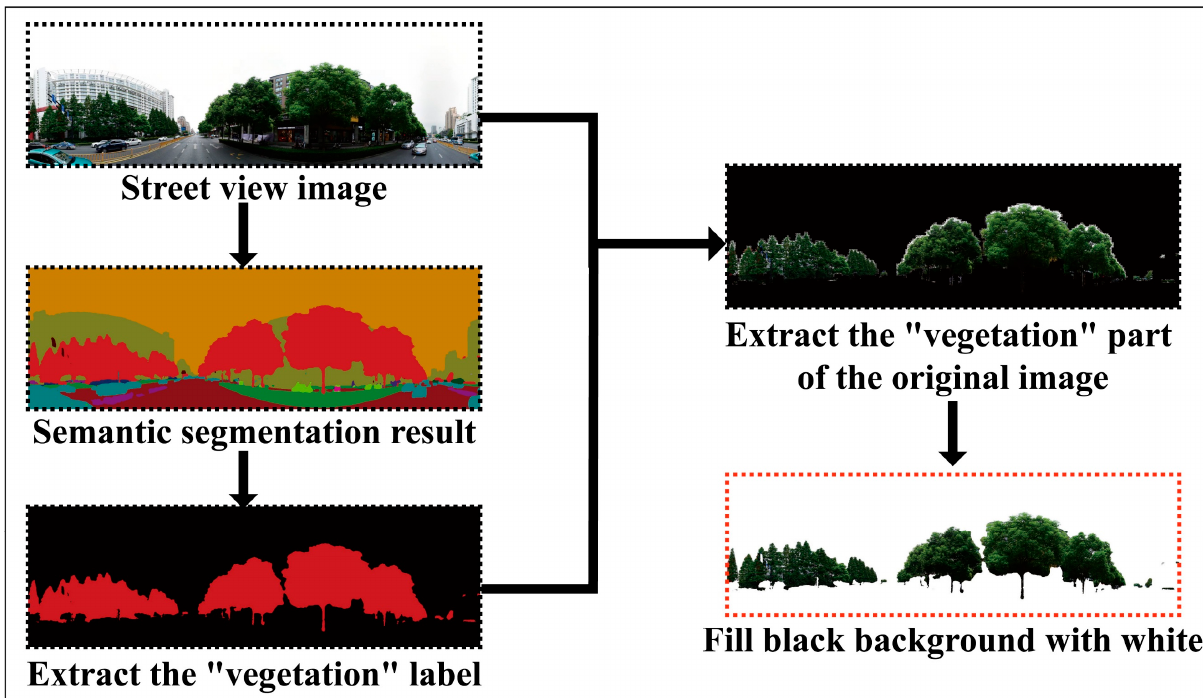
Figure 3. Street view image preprocessing process.